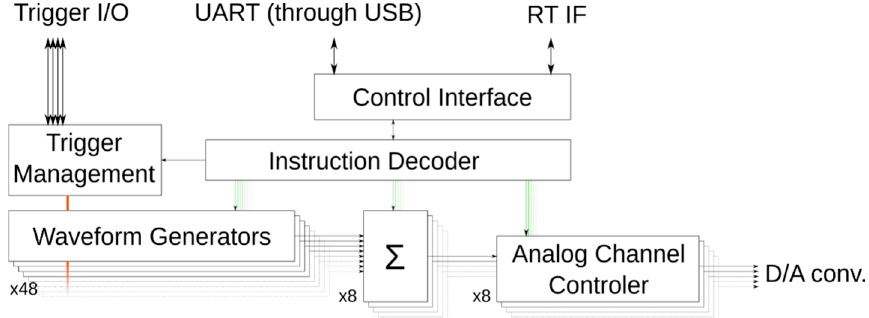
Figure 7. Description of digital architecture. Stimulation commands are received by the Control Interface and the Instruction Decoder through a USB/UART bridge or through a proprietary Real- Time interface (RT IF). The Instruction Decoder controls all Waveform Generators and manages the adders to feed the eight Analog Channel Controllers that are the direct interface to the Digital to Analog converters. Stimulations can be initiated by triggers and all waveforms are synchronized by the Trigger Management unit.